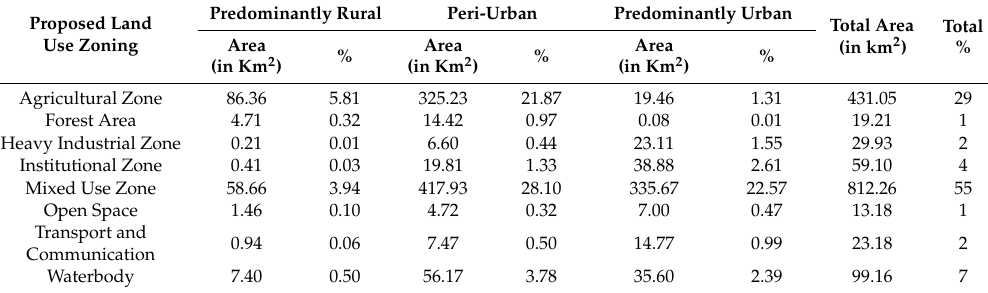
Table 7. Aerial statistics of the proposed land use zone (derived from the CRDP 2015–2035